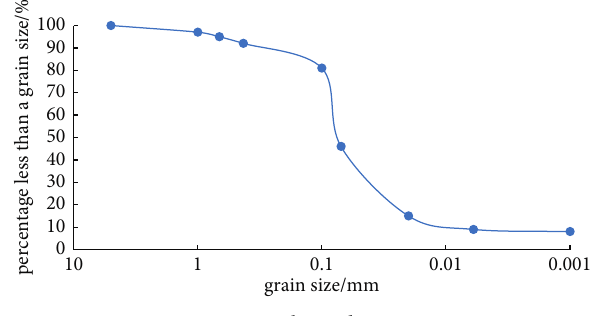
Figure 2: Particle gradation curve. Table 2: Soil sample gradation parameter